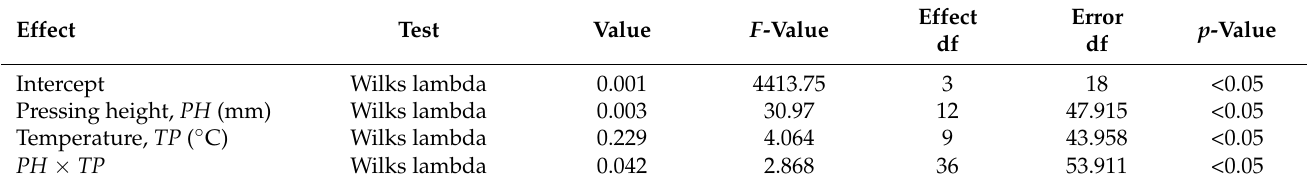
Table 2. Multivariate tests of significance of the factors’ effects on the calculated parameters.